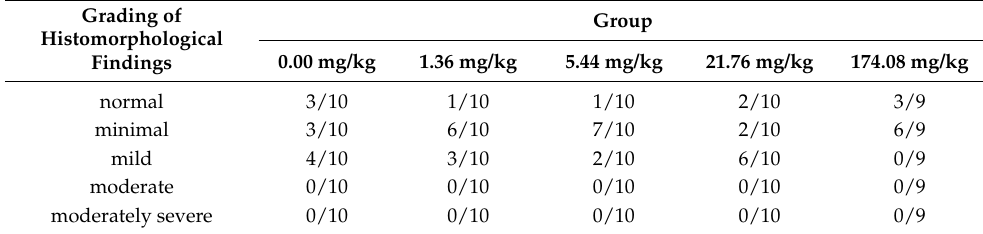
Table 6. Graded results of eosinophilic glassy droplet scoring in the kidneys of rats at the end of the AQ trial.